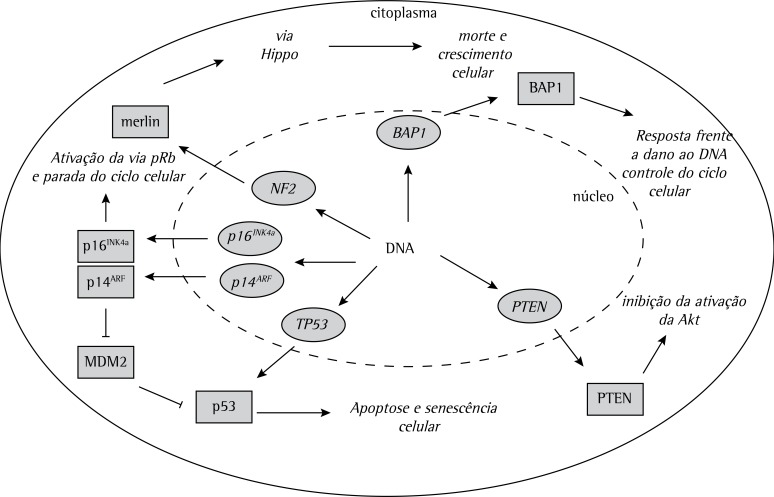
Envolvimento dos genes e suas respectivas proteínas no desenvolvimento
do mesotelioma maligno. As proteínas p16INK4a e p14ARF atuam na ativação da
via da proteína do retinoblastoma (pRb) e modulação da p53, respectivamente.
O NF2 codifica a proteína merlin, a qual atua com um regulador upstream da
via bioquímica Hippo. BAP1 codifica a proteína BRCA1 associated protein-1
(BAP1 proteína-1 associada a BRCA), que é responsável na resposta frente a
danos ao DNA e também no ciclo celular. PTEN codifica a proteína phosphatase
and tensin homolog (PTEN, homólogo de tensina e fosfatase), a qual é uma
importante reguladora negativa da via PI3K/Akt. A p53 atua de forma chave no
controle da apoptose e senescência celular.